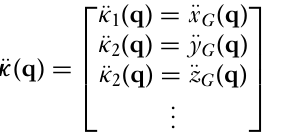
Figure 4 The ankle torques are applied to each